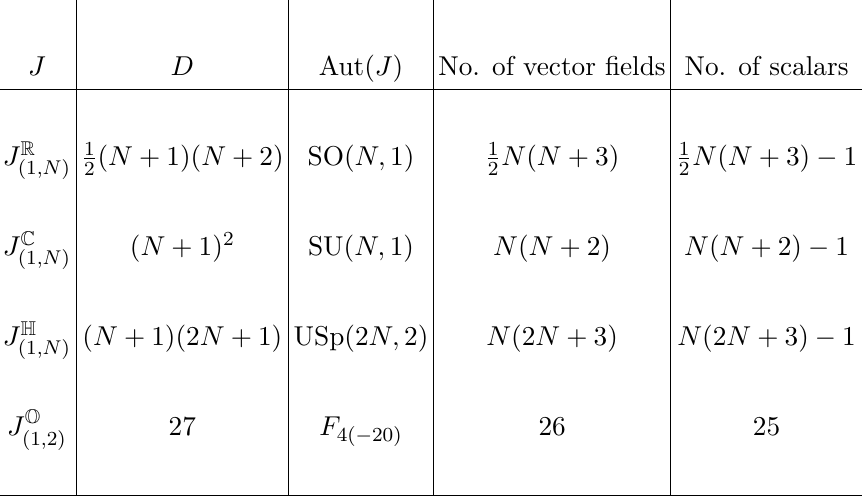
Table 1 . Simple Lorentzian Jordan algebras J A . Second and third columns list their dimensions (1 ,N ) D and automorphism groups Aut ( J A ) . Third and fourth columns list the number of vector fields (1 ,N ) ( D − 1) and the number of scalars ( D − 2) in the N = 2 MESGTs defined by